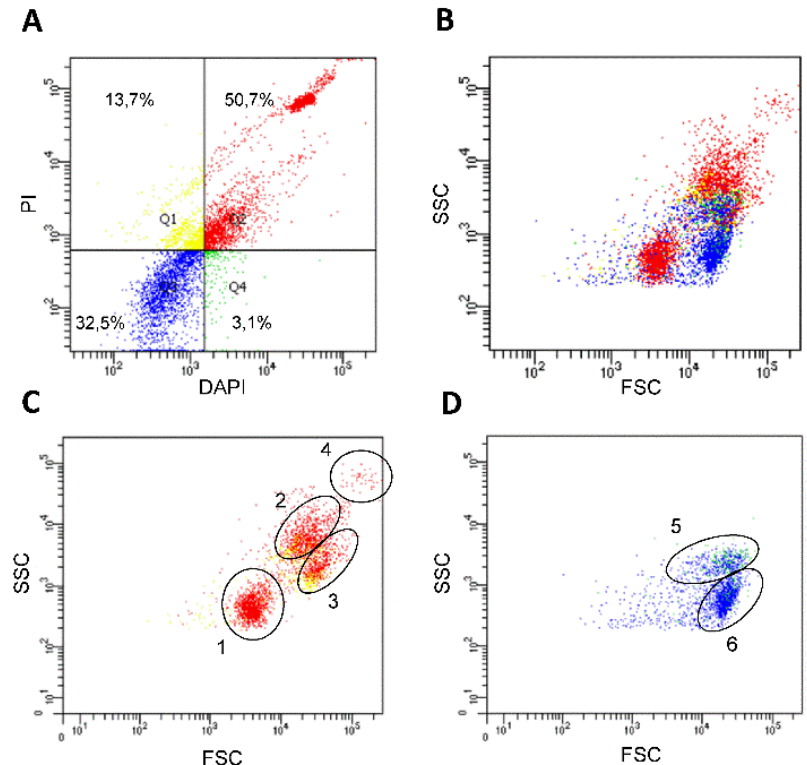
Figure 7. Hemocyte analysis by flow cytometry. Hemolymph samples were probed with PI and DAPI as described in Materials and Methods. ( A ) Dot-plot showing four groups as determined in comparison with controls employing only PI, DAPI or no fluorophore. ( B ) FSC vs SSC plot of the four groups displaying information of size and complexity, respectively. ( C , D ) are FSC vs SSC plots of Q1–Q2 and Q3–Q4 of ( A ) in matching colors. Numbers 1 to 6 are cell populations that can be grouped by size and complexity. The experiment was conducted by quintuplicated (n = 5) and each analyzed sample corresponded to the hemolymph collected from one insect. The panel shows the data of a representative experiment.